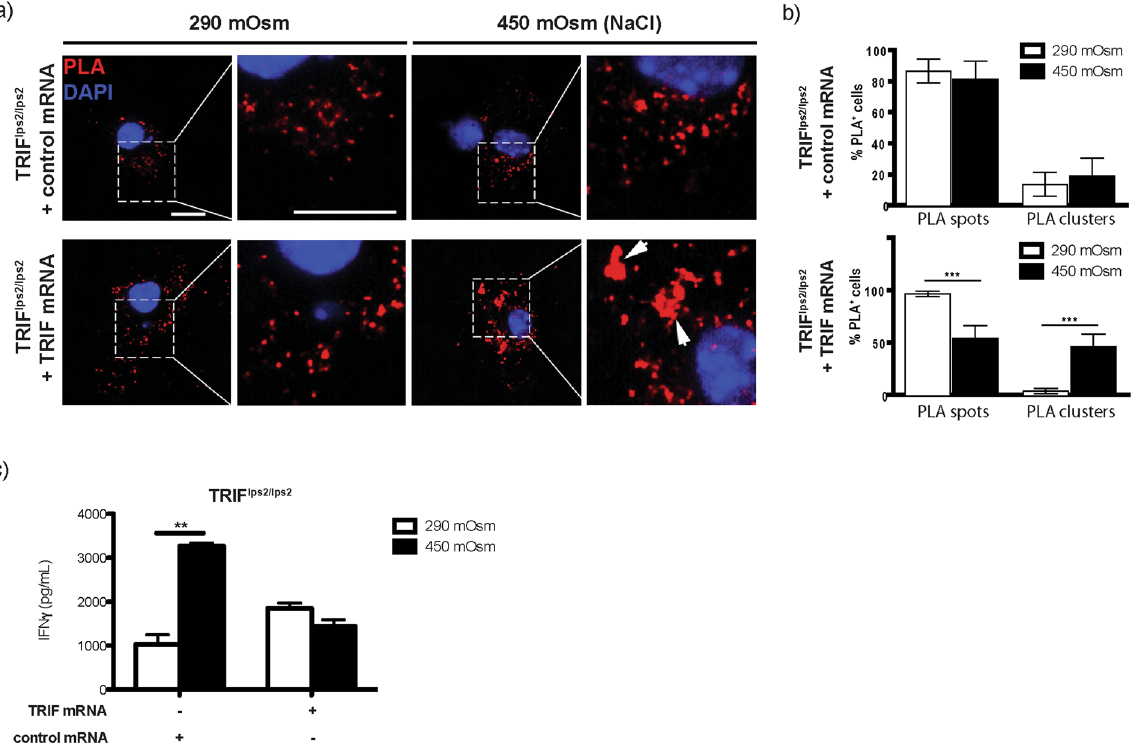
Figure 7. Overexpression of TRIF in TRIF-deficient BMDCs rescues the phenotype leading to both increased surface cluster formation and reduced OTI activation upon exposure to high salt. BMDCs from TRIF lps2/lps2 exposed to isotonic or hypertonic (450 mOsm) conditions were electroporated with 15 µ g control or TRIF mRNA. Cells were further incubated with OVA grade VII (1 mg/mL) for 4 hours, followed by overnight (17 hours) incubation with OTI cells. ( a ) Spots and clusters on BMDC surface upon exposure to hypertonic medium were assessed by PLA assay. The statistical graphs ( b ) show % of PLA-spot or –cluster positive cells in TRIF-deficient BMDCs overexpressed for TRIF (lower lane) or exposed to control mRNA (upper lane). ( c ) BMDCs obtained from the bone marrows of mice used for PLA assay were in parallel applied in OVA/ OTI activation assay (IFN- γ secretion measured from cell culture supernatants, displayed as mean ± SEM; *** p ≤ 0.001 and ** p ≤ 0.01, n =